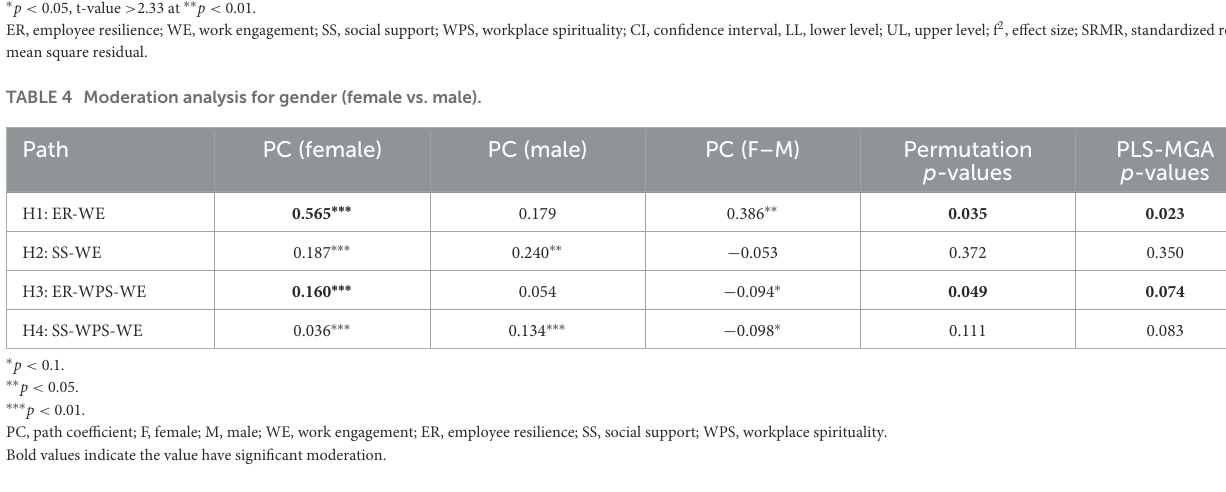
TABLE 5 Moderation analysis by age (younger vs. older).